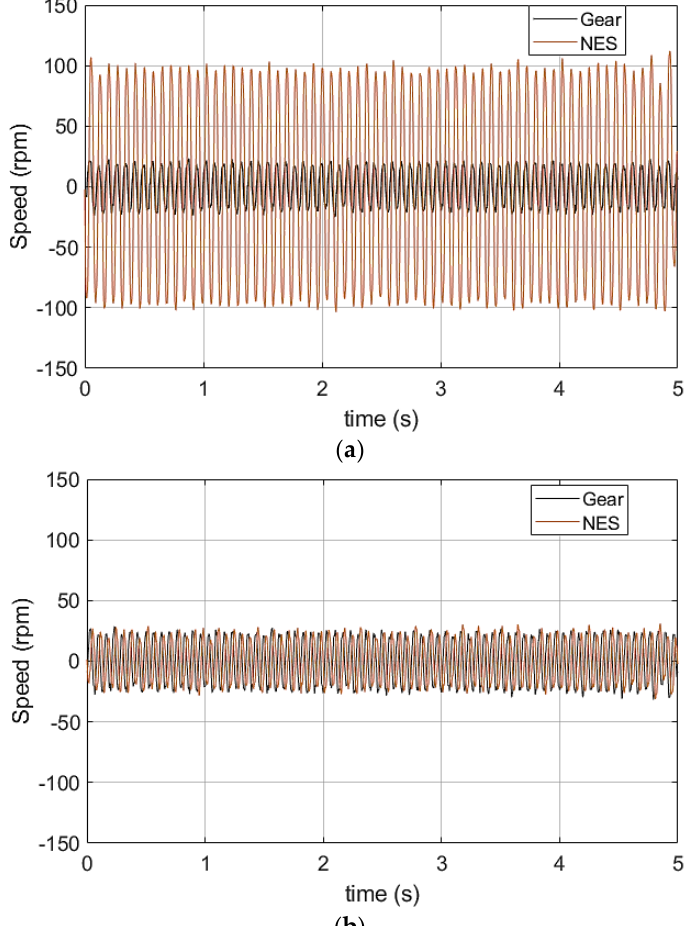
Figure 13. Time histories of the gear and the NES vibrations for active NES and mean speed of the pinion; ( a ) 800 rpm and ( b ) 900 rpm.